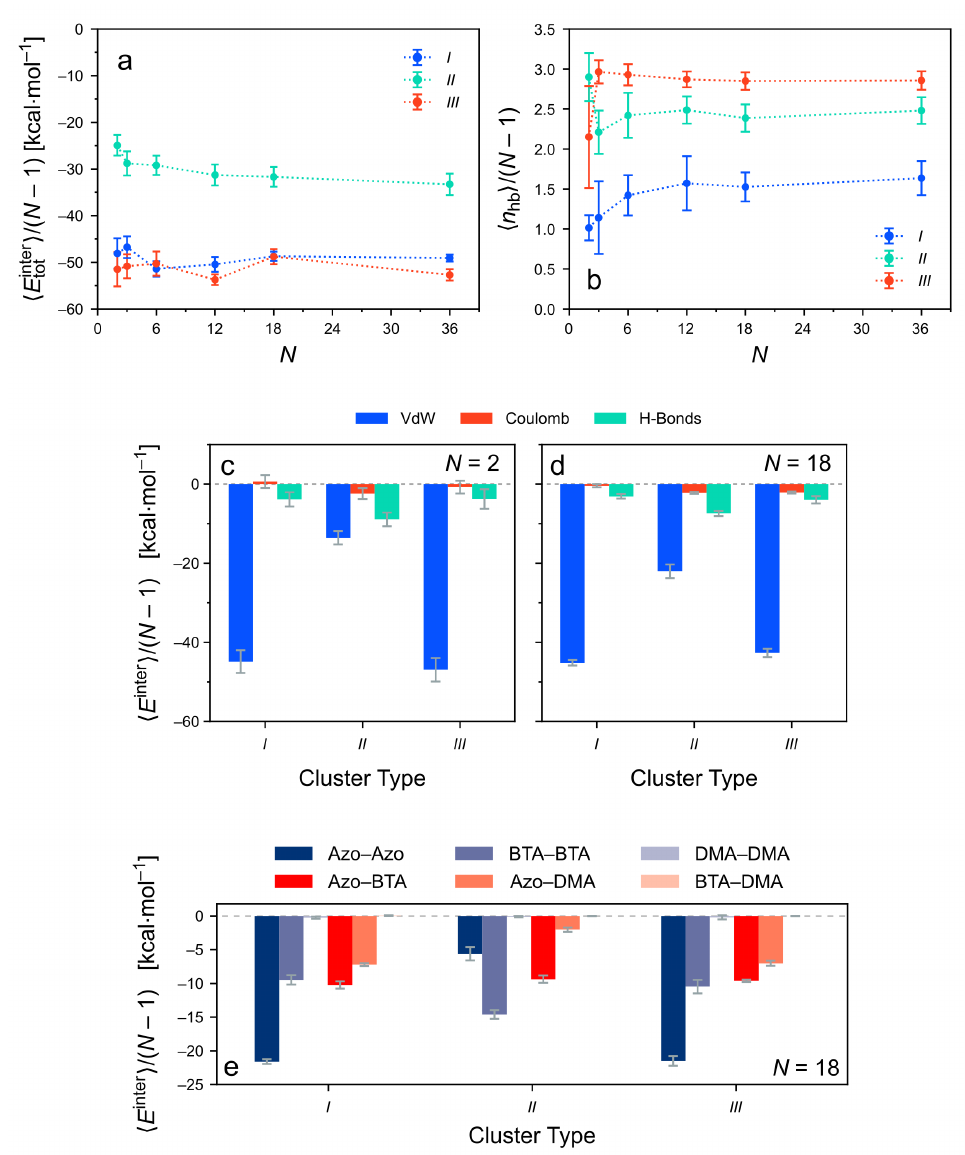
Figure 12. Intermolecular energies and hydrogen bonding in the TrisAzo stacks in their initial state (first 0.1ns of the equilibration run). ( a ) Total intermolecular energies, ( b ) average number of hydrogen bonds per neighboring pair, ( c , d ) decomposition of the intermolecular energy by types of non-covalent interactions, and ( e ) decomposition of the intermolecular energy by interactions between different molecule parts. Dashed and dotted lines serve as a guide to the